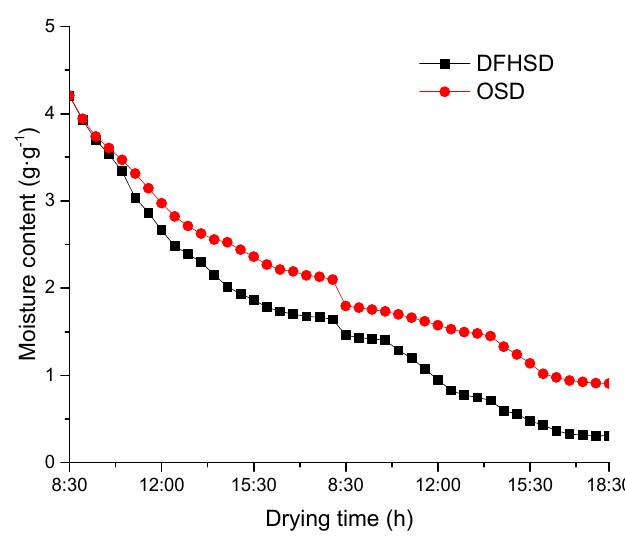
Figure 7. The change of lemon slices moisture content.